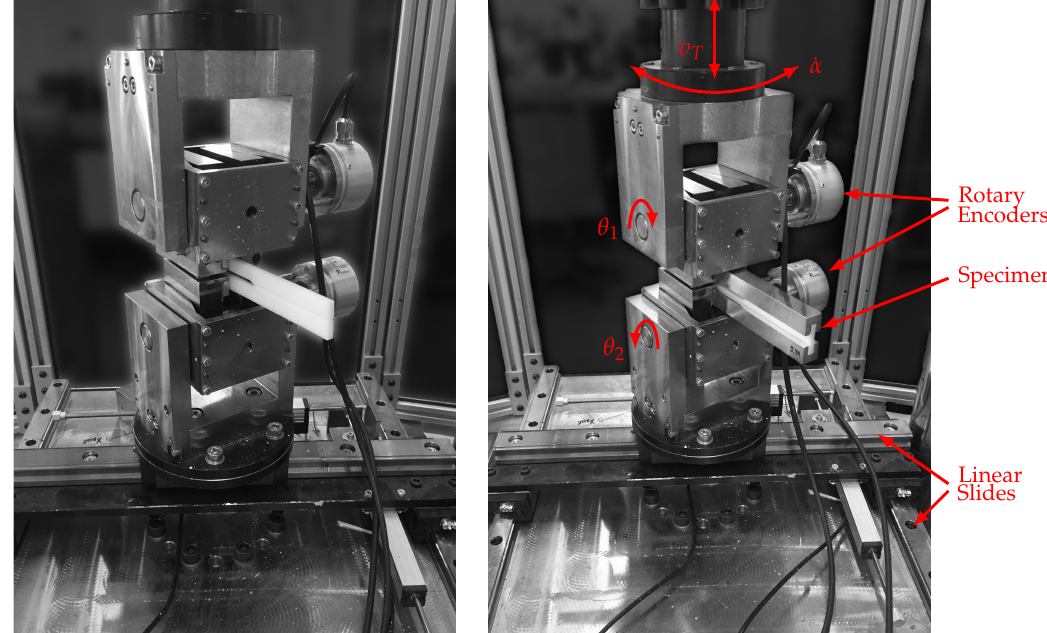
Figure 6. Experimental setup with POM-H specimens. Mode I setup ( left ) and mode III setup ( right